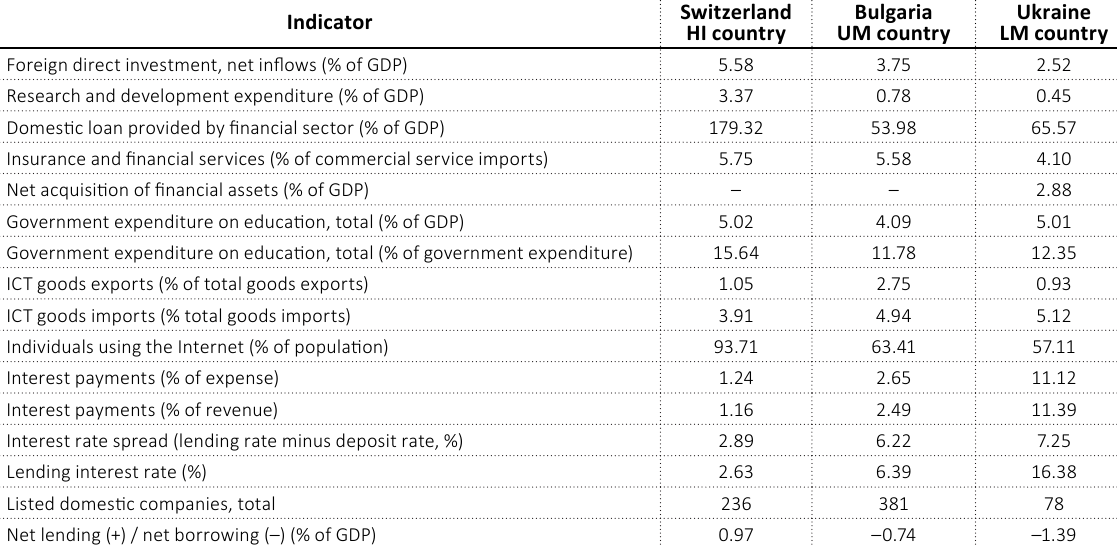
Table 3. Indicators of financial instruments usage effectiveness in the innovative business environment, on average in